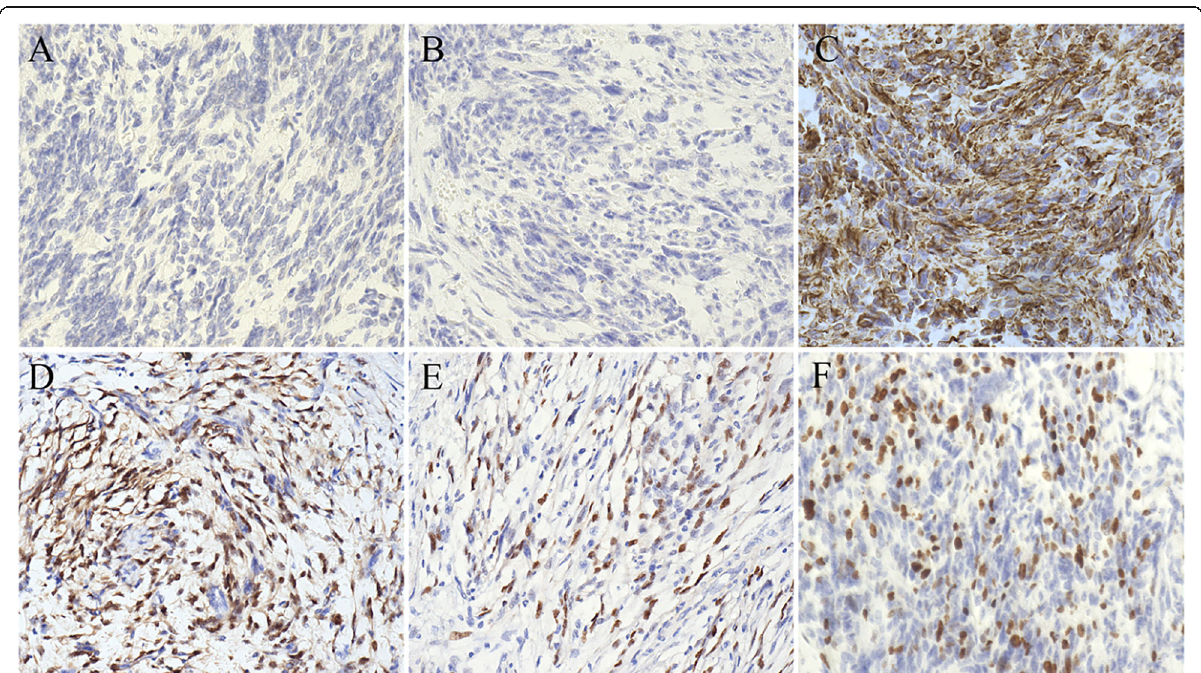
Fig. 3 Immunohistochemical staining of vaginal dedifferentiated liposarcoma. Negative expression of Desmin ( a ) and Ck-pan ( b ) was detected, while expression of Vimentin was diffuse and strong in the tumor cell ( c ) using immunohistochemical staining. The combination markers of